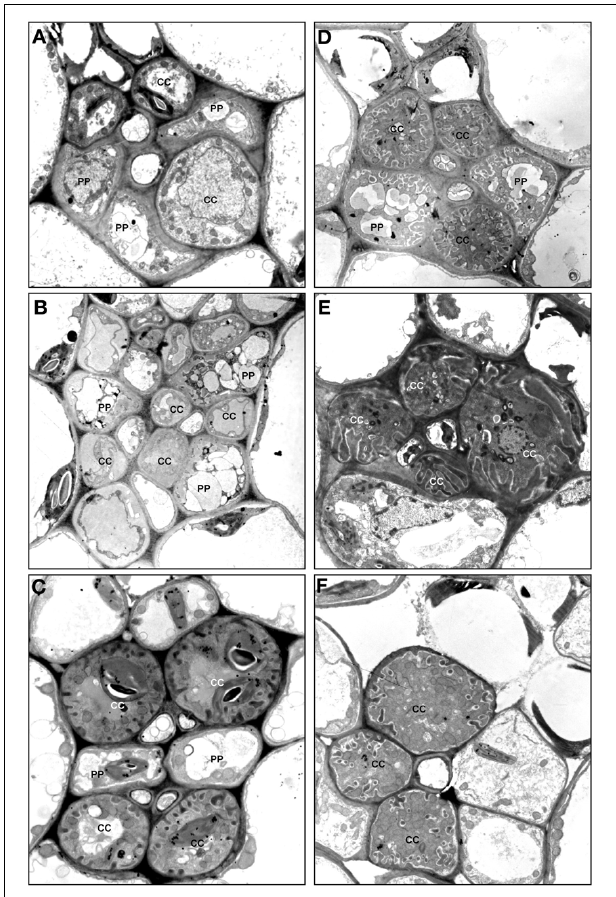
FIGURE 5 | Structure of minor vein phloem, type 2. (A) Ehretia cordifolia , subtype 2-I; (B) Veronica chamaedrys , subtype 2-II; (C) Galium krylovianum , subtype 2-III; (D) Aster alpinus , subtype 2-IV; (E) Gentiana aquatica , subtype 2-V; (F) Rhinanthus minor , subtype 2-VI. CC, companion cell; PP, phloem parenchyma; SE, sieve element. Magnification: (A,F) × 1700; (B) × 2000; (C, E) × 3000; (D) × 4000.